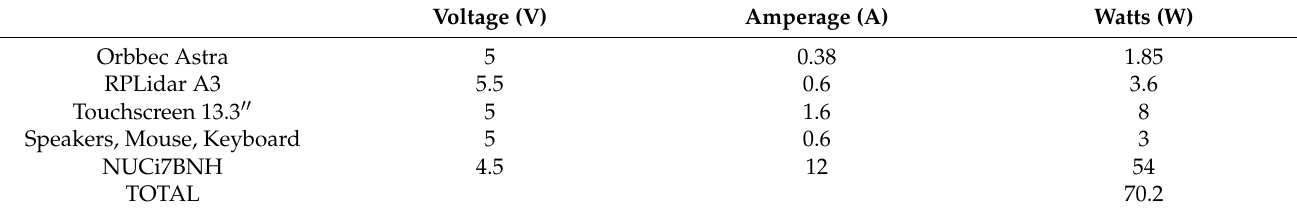
Table 5. Power consumption of the main components of the